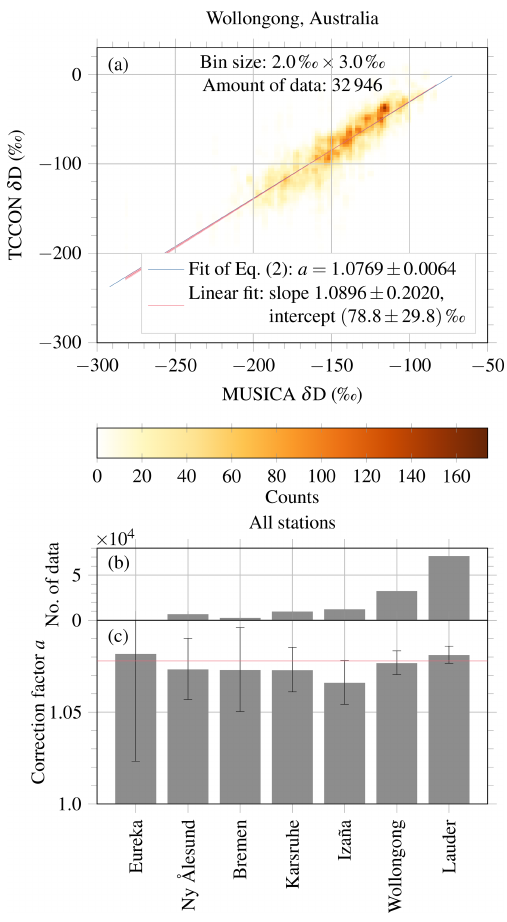
Figure 4. (a) Exemplary correlation histogram of TCCON δ D vs. MUSICA δ D for Wollongong, Australia. The blue line shows the result of a fit of Eq. (2), giving the correction factor for TCCON HDO. The red line shows a linear fit of slope and intercept, and the red shading represents the confidence interval computed using the bootstrap method. (b) Number of co-located measurements for all stations in both networks. (c) Fit results of correction factors for individual stations. The red line corresponds to the error-weighted average over all stations, a = 1 . 0778.